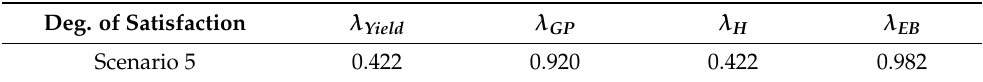
Table 10. Degree of satisfaction λ for Scenario 5.